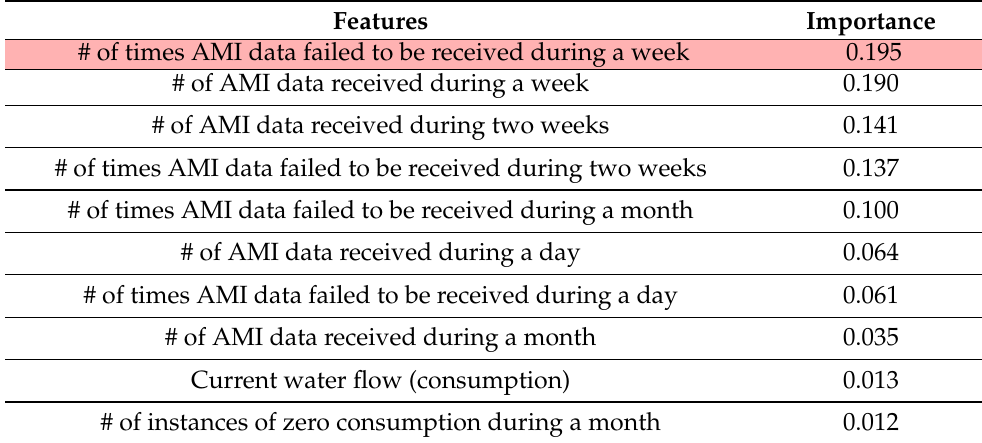
Table 4. Top ten selected features and their importance. The highlighted feature is the most important feature